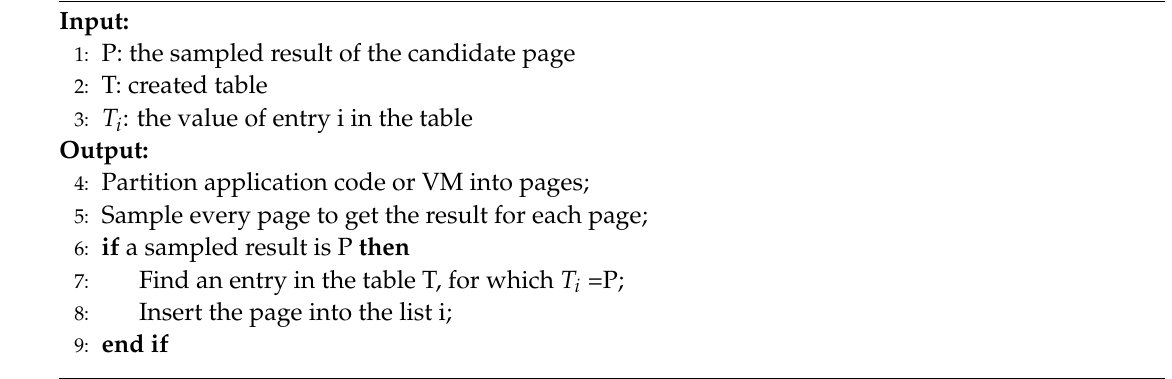
Algorithm 1 Page Classification algorithm